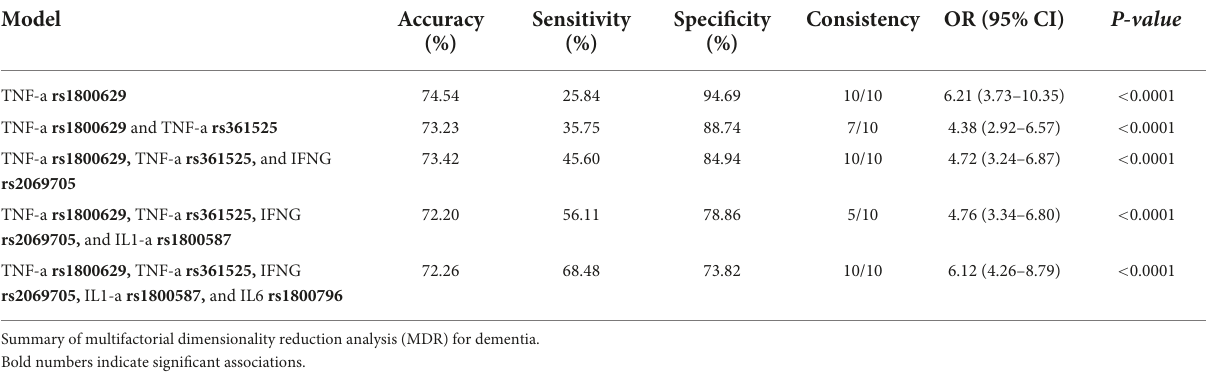
TABLE 4 Analysis of interactions to measure dementia susceptibility.